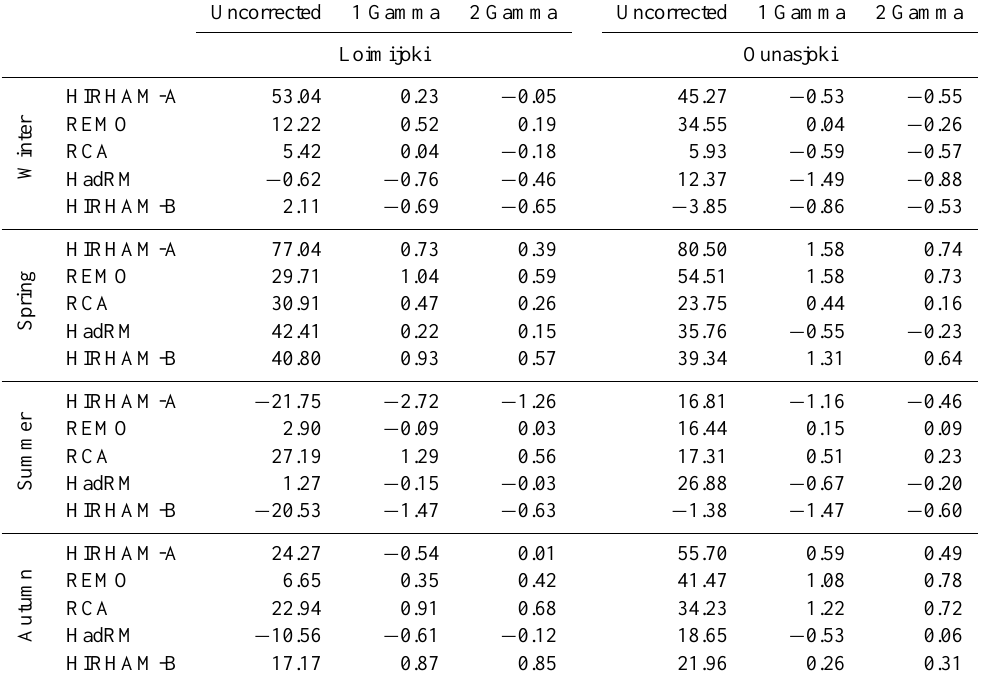
Table 2. Deviation between observed and RCM accumulated seasonal precipitation during control period 1961–2000 in uncorrected and DBS-adjusted (single gamma is 1 gamma, double gamma is 2 gamma) precipitation in percent. Values are shown for Loimijoki in southern Finland and Ounasjoki in northern Finland to demonstrate the spatial variation. 1